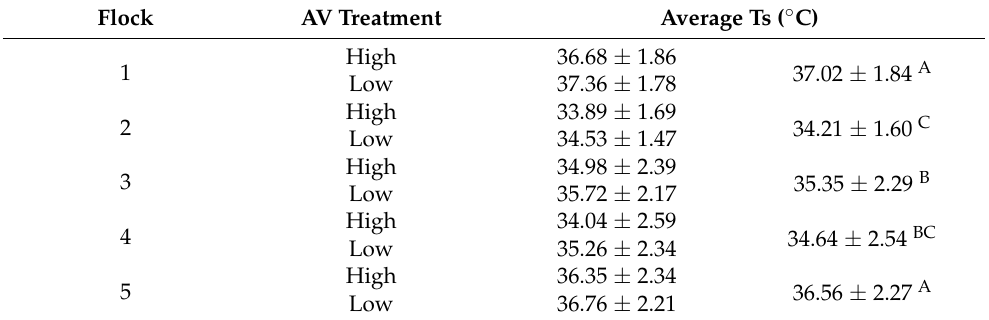
Table 7. Mean surface temperatures of heavy broilers under two AV treatments in the summer